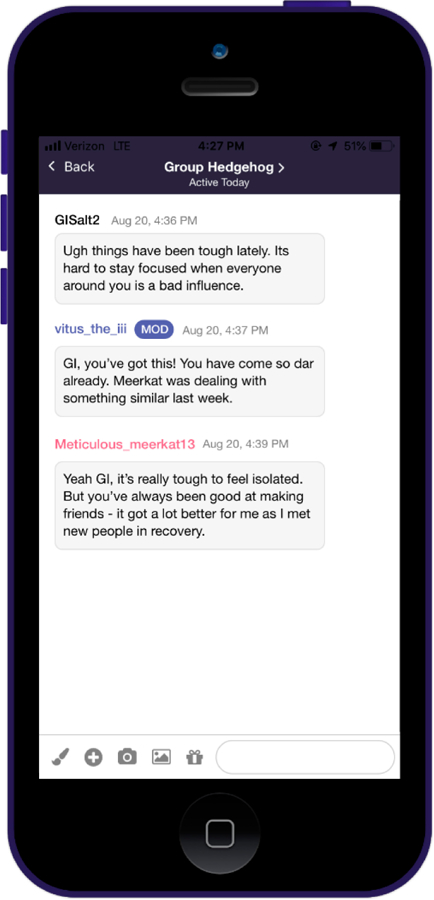
Moderator Screen.